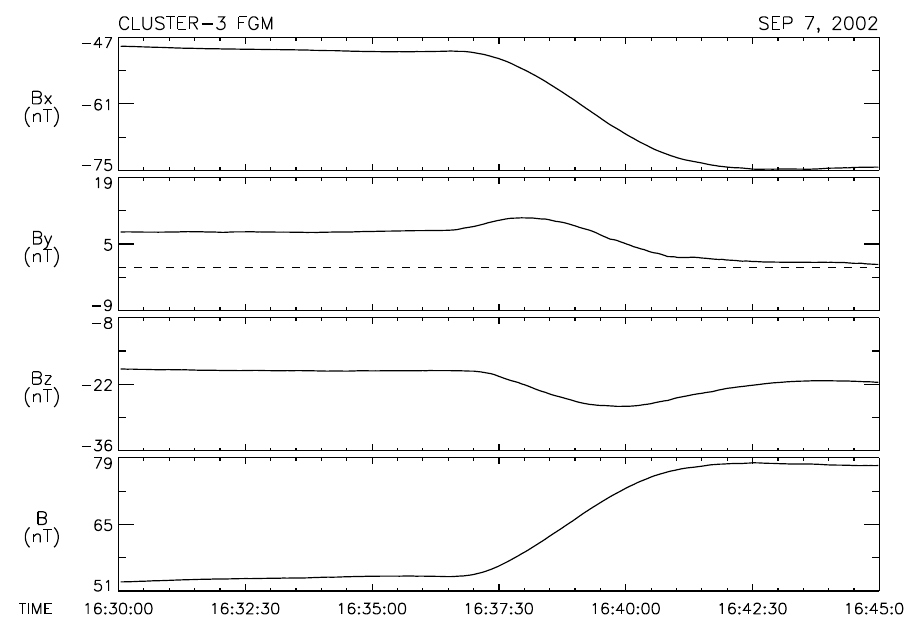
Fig. 10. Tail lobe SI event on 7 September 2002. Panels show magnetic field components in the GSM coordinate system and the magnetic field magnitudes. Cluster was located at a GSM position of ( − 9.95, 0.23, − 10.26) R E